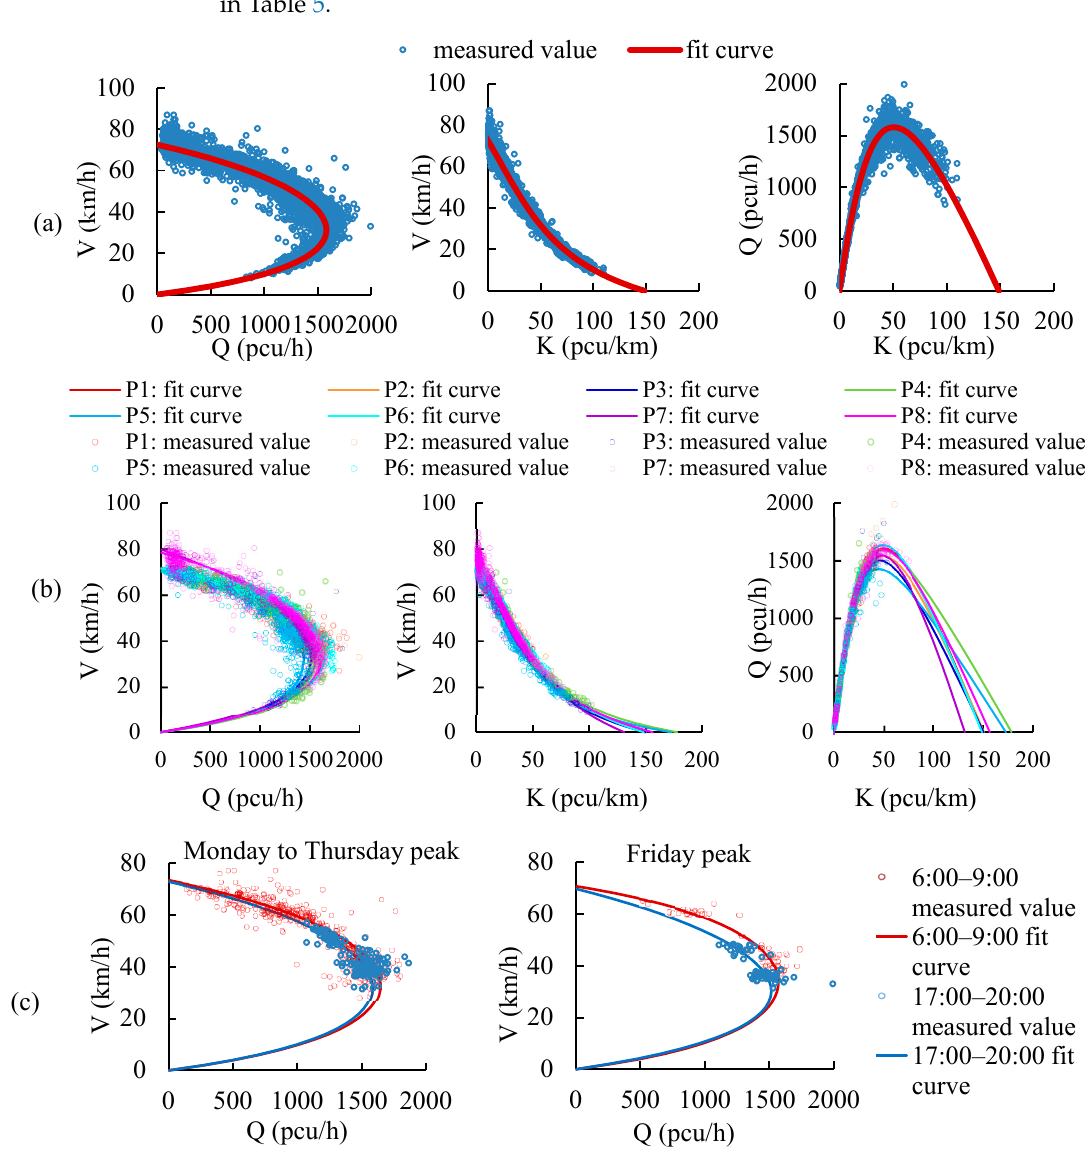
Figure 12. Fundamental diagram models of different proposals on expressways: ( a ). Proposal I, ( b ). Proposal II, ( c ). Proposal III.